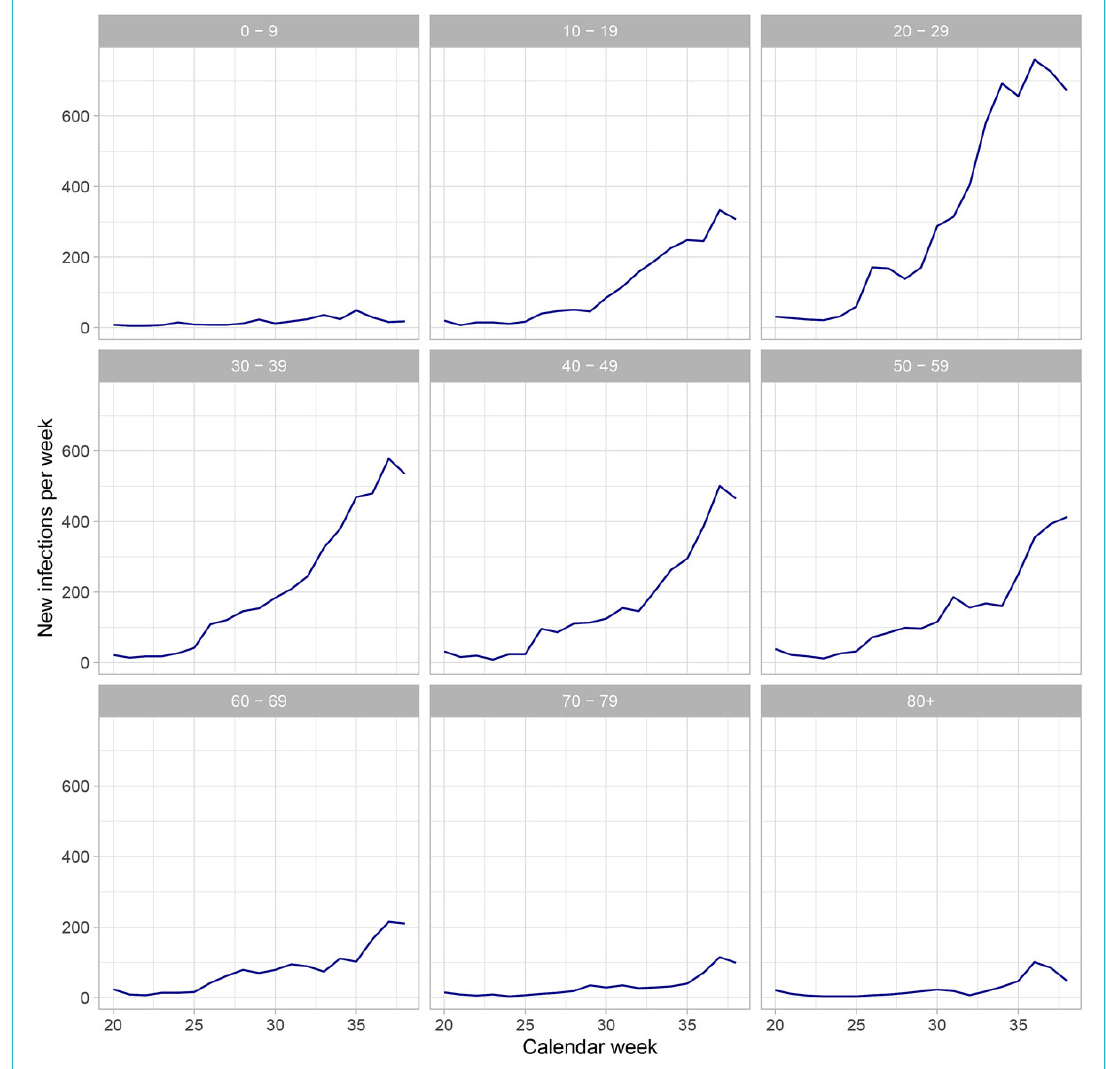
Figure S1: Absolute numbers of new infections in Switzerland per week across different age groups following the release of the lockdown from May to late August 2020 (calendar week 20 to 38). Source: Federal Office of Public Health